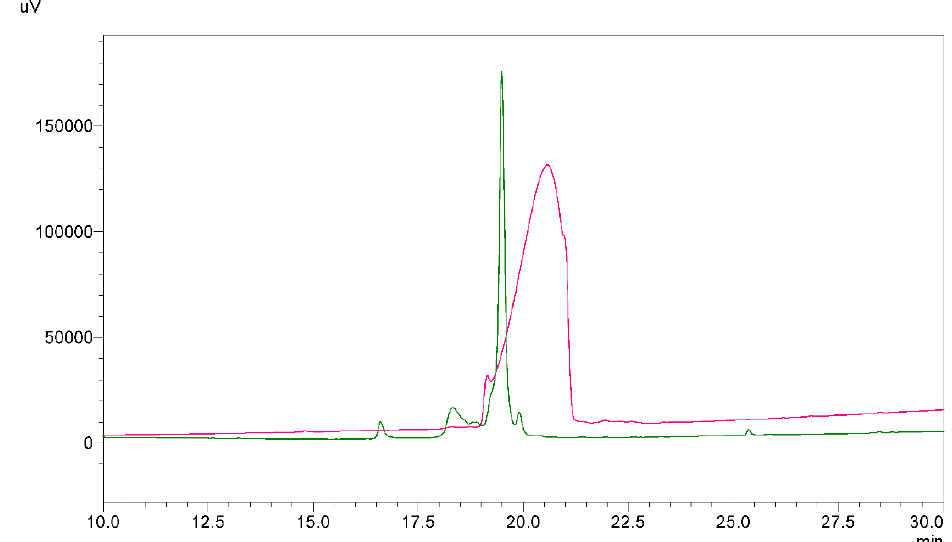
Figure 8. Chromatograms of commercial HBD-3 (pink trace) and HBD-3 #1 synthesized with orthogonal disulfide bond formation strategy (green trace).